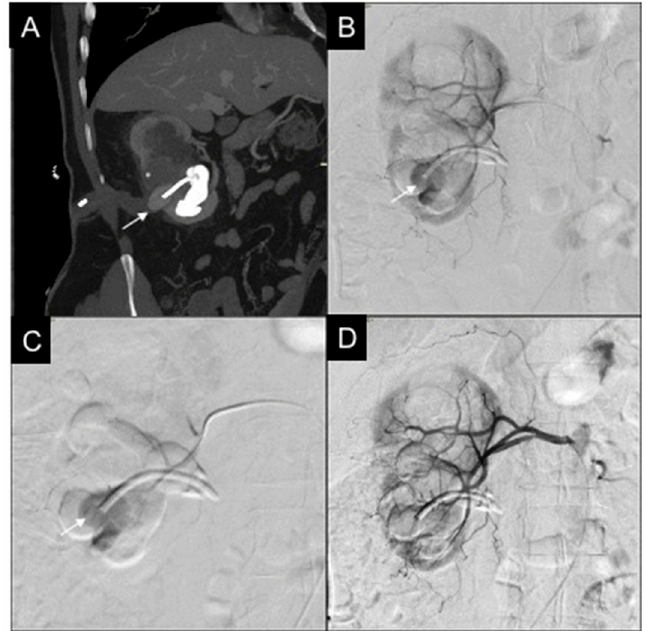
Figure 1. 46-year-old male, affected by iatrogenic PA. ( A ) CT reconstruction with MIP and coronal oblique MPR, in venous phase, shows the PA (white arrow) in correspondence with the point of entrance of the nephrostomy into the renal cortex; amount of intracaliceal contrast agent residual from the urological procedure. ( B ) Selective right renal DSA confirms PA (white arrow). ( C ) Microcatheter positioning into the feeder of the PA (white arrow). ( D ) Final DSA showing PA resolution after embolization with a microvascular plug (MVP-5Q), renal parenchyma normally vascularized.